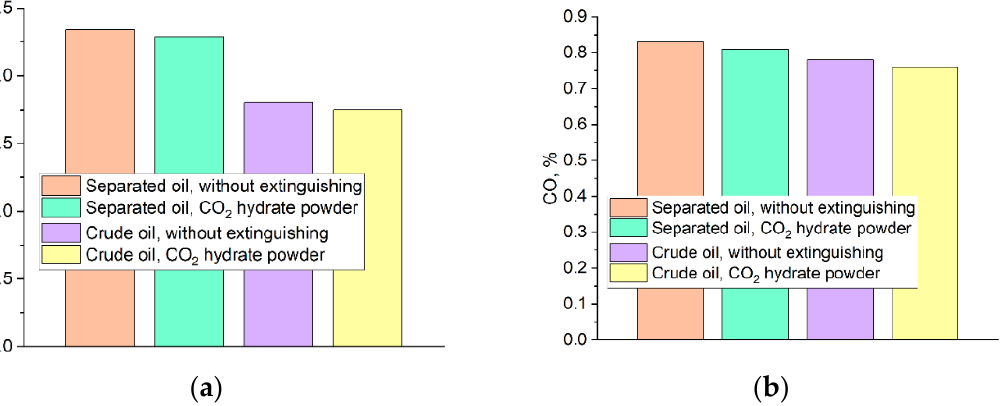
Figure 11. Concentrations of CO 2 ( a ) and CO ( b ) released during the suppression of crude and separated oil fire by CO 2 hydrate.